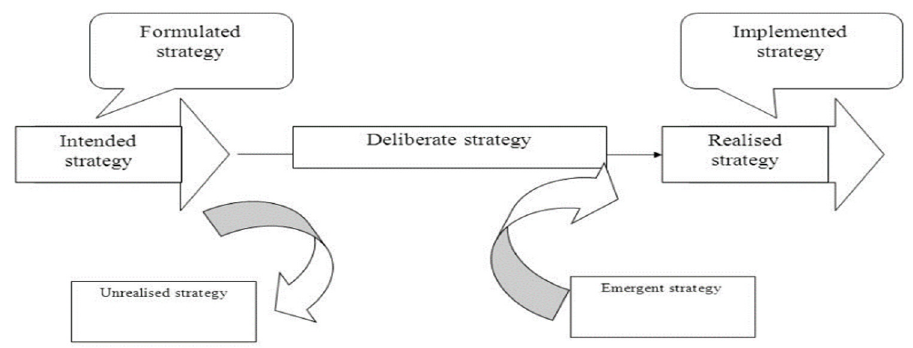
Figure 1. Pattern in strategy formation. Source: Based on H. Mintzberg: “Management Science May 198; 24, P.945”.